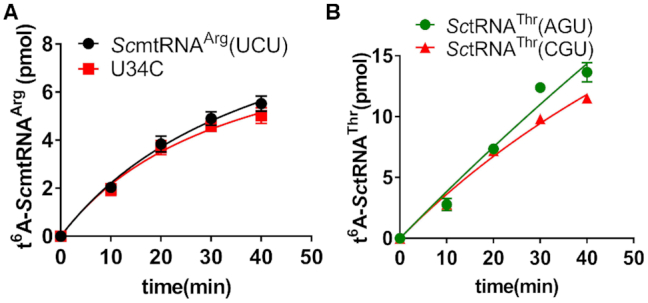
C34 is not an anti-determinant for the yeast t6A modification machinery. (A) t6A modification levels of ScmtRNAArg(UCU) (red filled circles) and ScmtRNAArg(UCU)-U34C (black filled squares) determined with Sua5/Qri7. (B) t6A modification levels of SctRNAThr(CGU) (red filled triangles) and SctRNAThr(AGU) (green filled circles) determined with Sua5/ScKEOPS.